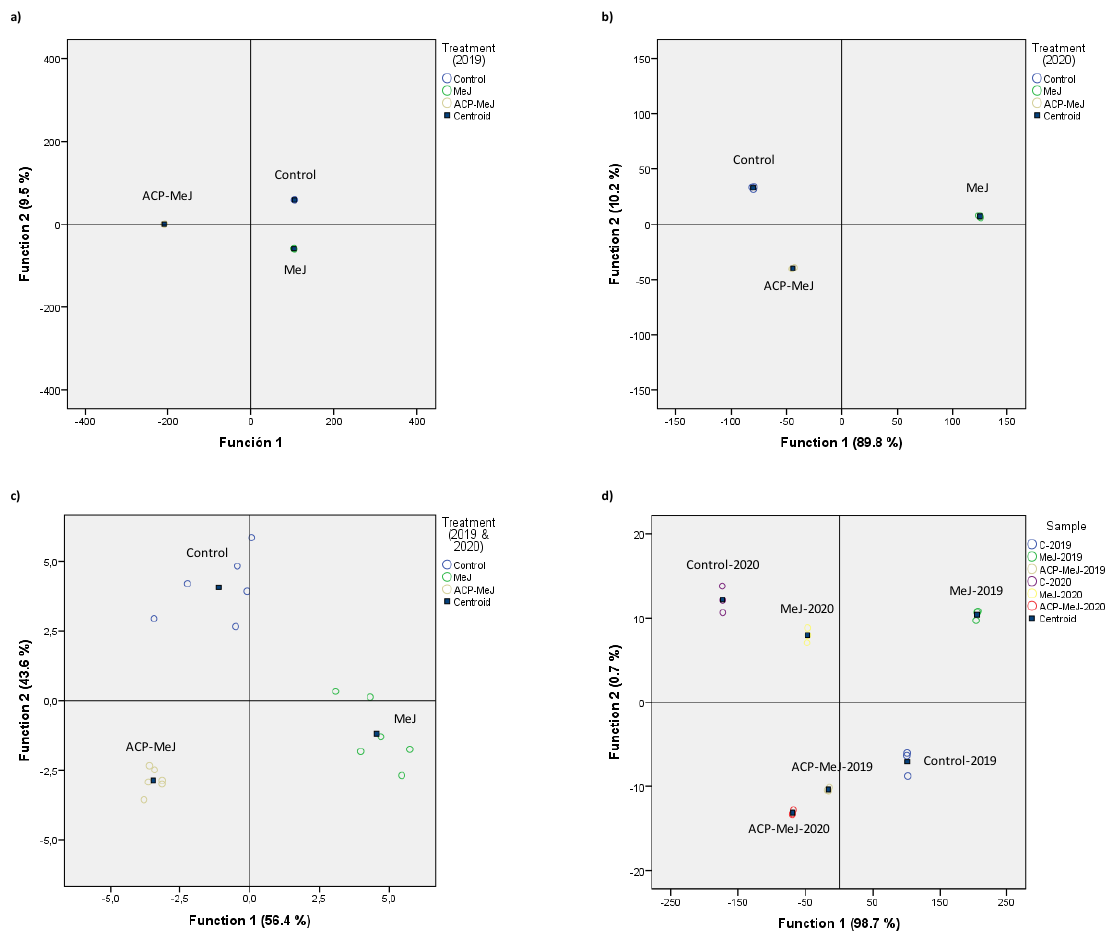
Figure 4. Discriminant analysis of volatile compounds content ( µ g/L) in grapes from control, methyl jasmonate (MeJ) and nanoparticles doped with this elicitor (ACP-MeJ) treatments, in ( a ) 2019, ( b ) 2020, and ( c ) 2019 & 2020 seasons, carried out with the treatment as factor; and ( d ) carried out with the sample as factor.